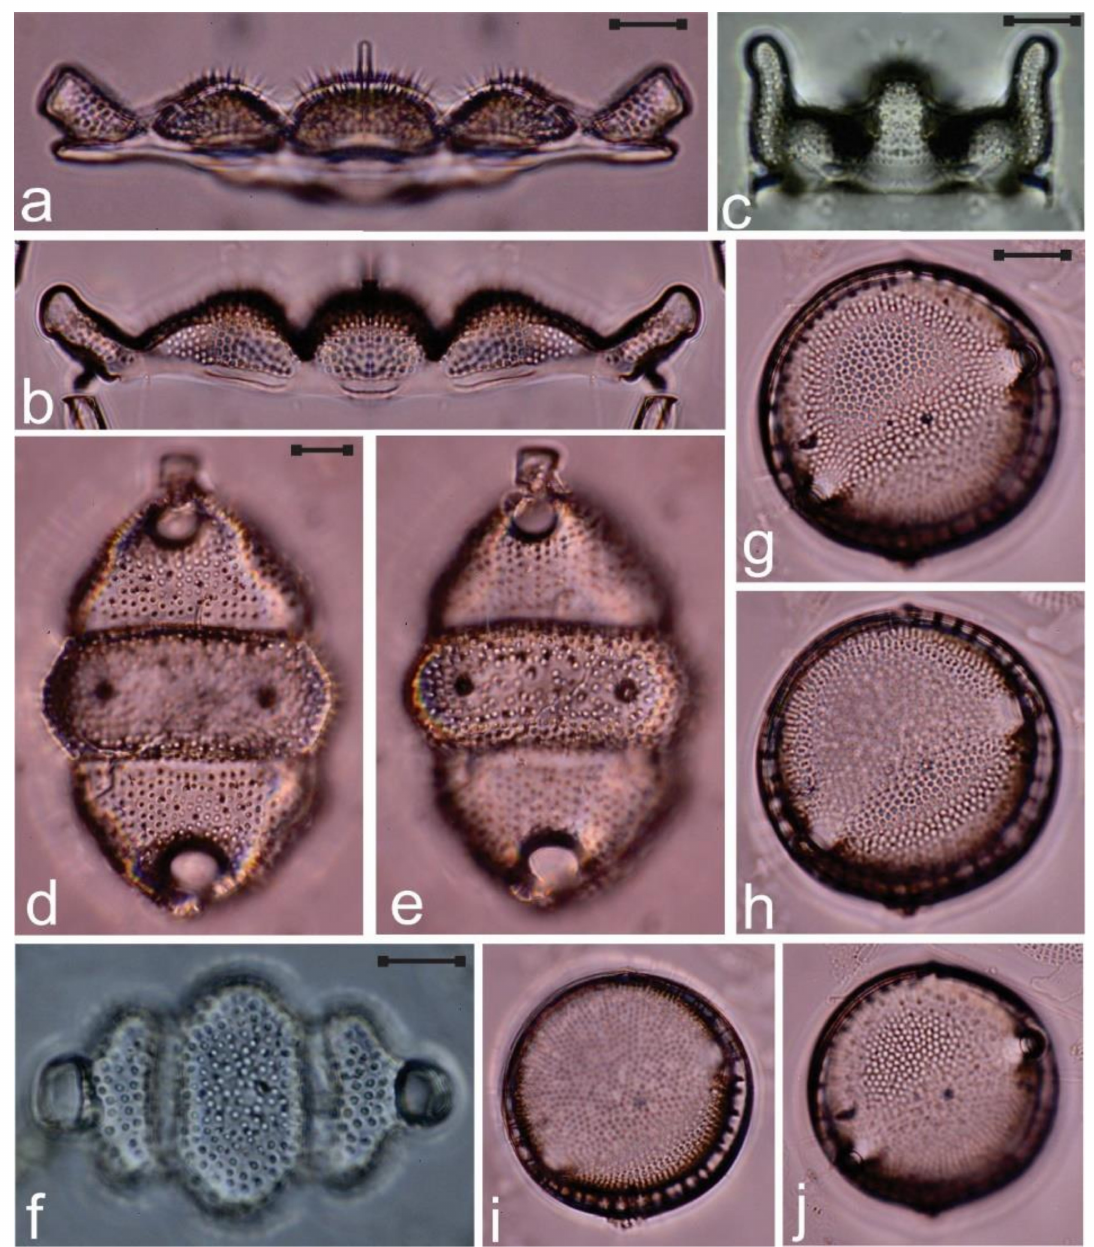
Figure 11. ( a – c , f ) Biddulphia tridens, images a – c girdle view, image f valve view; ( d , e ) B. tridentata valve at two focal planes; ( g – j ) Ralfsiella smithii showing di ff erent focal planes. Scale bar = 10 µ